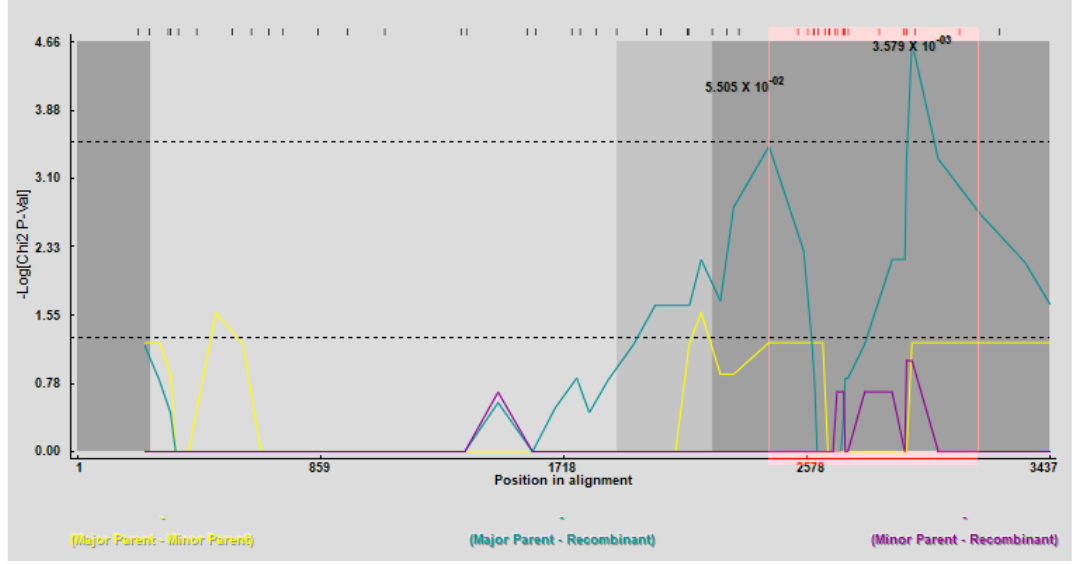
Figure 6. Recombination events detected in the full-length genome of STV populations. The x -axis indicates the position in alignment, while the y -axis denotes the Log[Chi2 P-Val]. Light green and light blue peaks indicate major and minor parents, respectively; the yellow peak marks both major and minor parents simultaneously. The recombination event corresponds to a recombinant isolate (OK309713) with major (OK309721) and minor (KT438549) parents. Table 3. Description of recombination events detected using RDP in the full-length genome and RdRp region of globally reported STV populations.